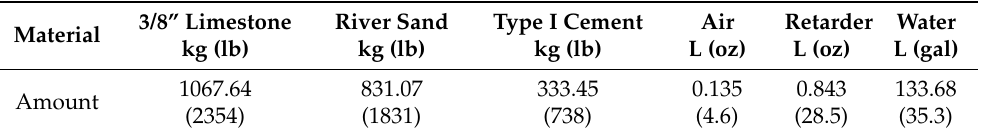
Table 2. Concrete Mix Design per m3 (yd3).